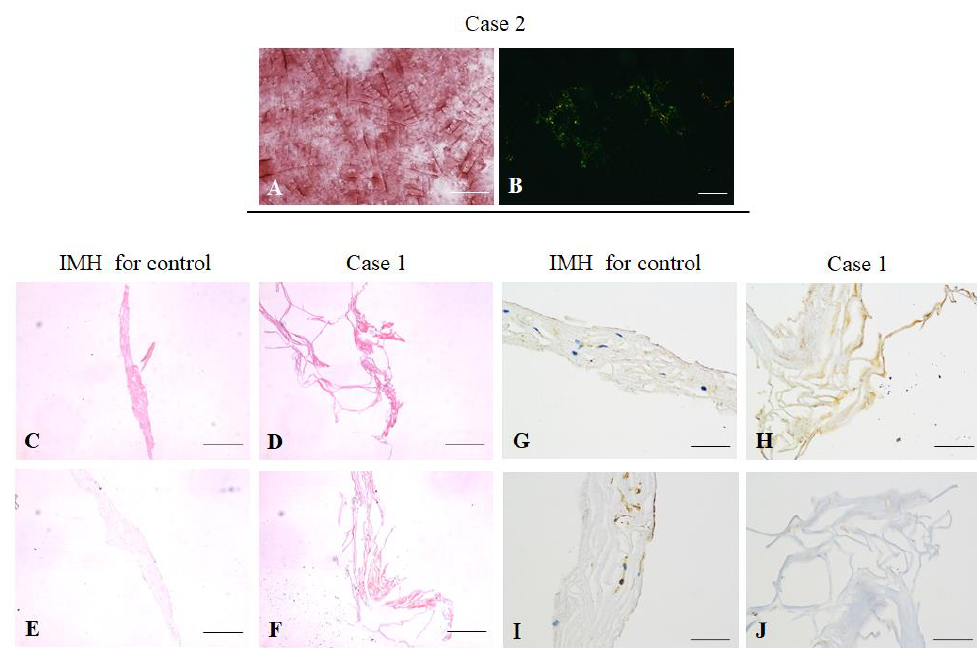
Figure 7. Histopathological examination. ( A , B ) Congo red staining of vitreous aspirates from case 2 under the light microscope and a characteristic apple-green birefringence under a polarized microscope. Scale bar: 200 μm . ( C , D ) Hematoxylin and eosin staining of the inner limiting membranes (ILM) from a patient with idiopathic macular hole (IMH) and case 1. Scale bar: 100 μm . ( E , F ) Positive Congo red staining of the ILM in case 1. Scale bar: 100 μm . ( G , H ) Immunohistochemical staining of ILM, showing increased transforming growth factor- β 1 expression in the ILM from case 1. Scale bar: 50 μm . ( I , J ) Immunohistochemical staining of the ILM showed no difference in vascular endothelial growth factor between case 1 and the patient with IMH. Scale bar: 50 μm .